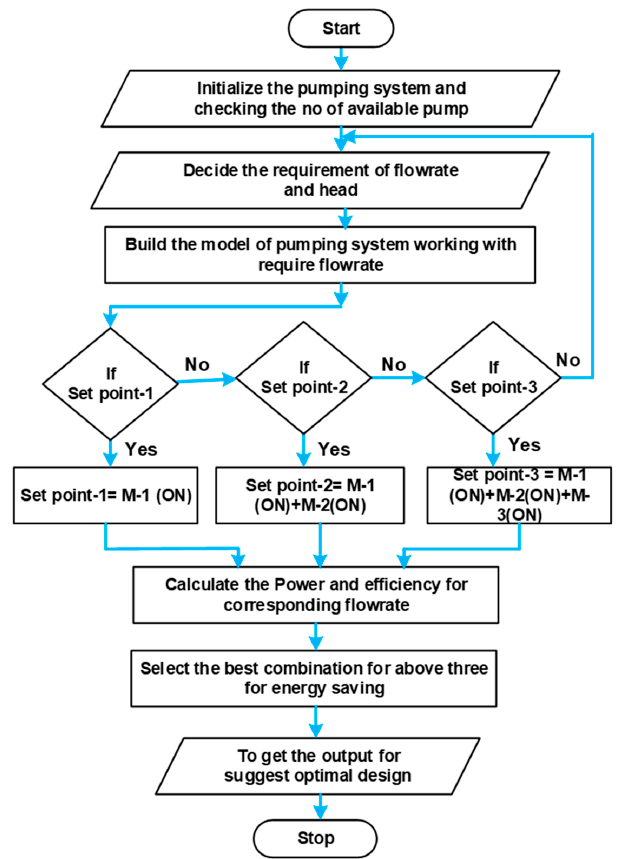
Figure 6. Parallel pump operation.